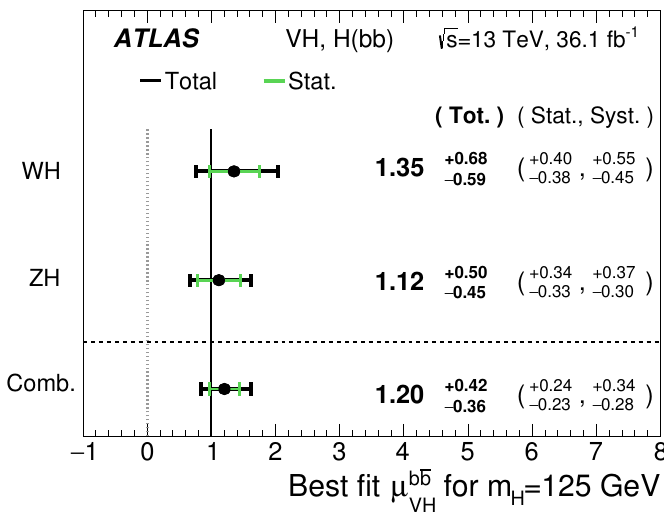
Figure 5 . The (cid:12)tted values of the Higgs boson signal strength parameter (cid:22) for m H = 125 GeV for the WH and ZH processes and their combination. The individual (cid:22) values for the ( W=Z ) H processes are obtained from a simultaneous (cid:12)t with the signal strength for each of the WH and ZH processes (cid:13)oating independently. The compatibility of the individual signal strengths is 75%.